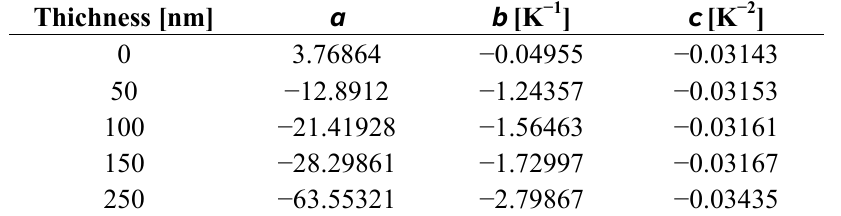
Table 1. Coefficients of the second order polynomial fit for the 5 TFCs in Figure 7.